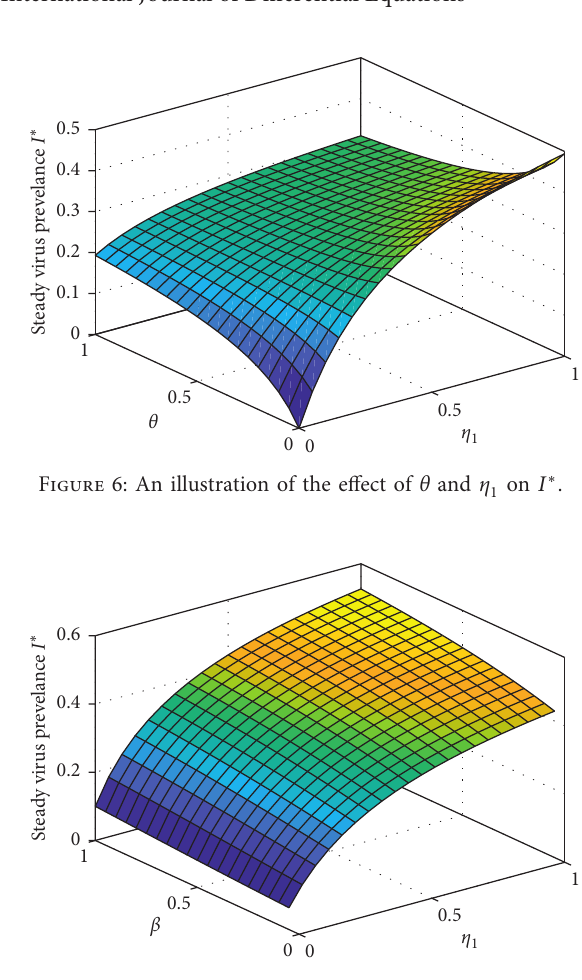
on I ∗ . Figure 10: An illustration of the effect of σ and ε on I ∗ . 1